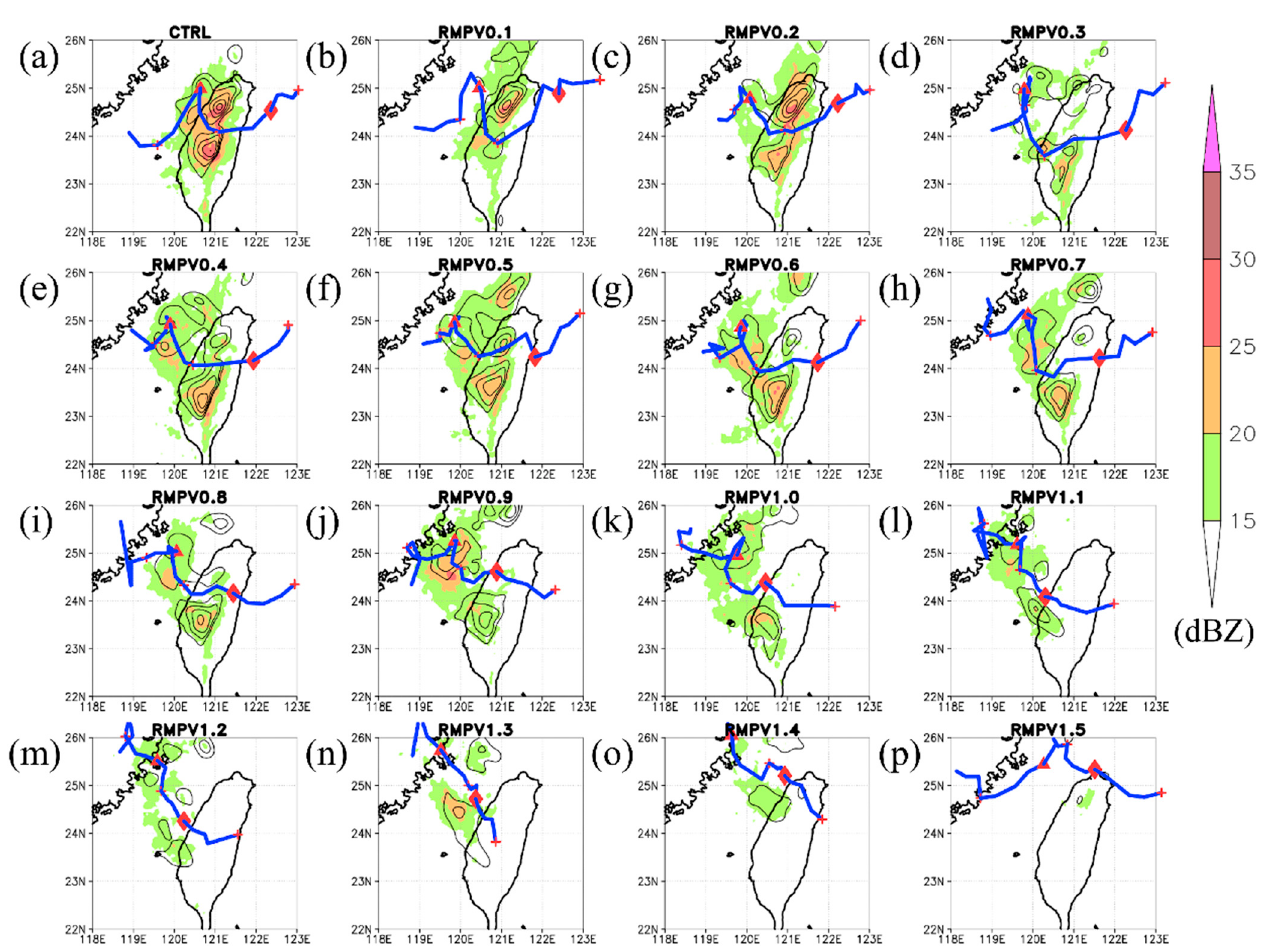
Figure 9. Simulated maximum reflectivity (shading; dBZ), 700 hPa vertical velocity (contours start at − 1 with intervals − 0.5; Pa s − 1 ) averaged from 0000 UTC 30 August ( − 24 h) to 1200 UTC 01 September (+36 h) and the 1-hourly track of 700 hPa vortex center (blue curves) in ( a ) CTRL, ( b ) RMPV0.1, ( c ) RMPV0.2, ( d ) RMPV0.3, ( e ) RMPV0.4, ( f ) RMPV0.5, ( g ) RMPV0.6, ( h ) RMPV0.7, ( i ) RMPV0.8, ( j ) RMPV0.9, ( k ) RMPV1.0, ( l ) RMPV1.1, ( m ) RMPV1.2, ( n ) RMPV1.3, ( o ) RMPV1.4 and ( p ) RMPV1.5. Triangle signs denote the center at 0000 UTC 31 August (0 h); diamond signs denote the center at 0000 UTC 1 September (+24 h); cross signs denote the center at 1200 UTC every